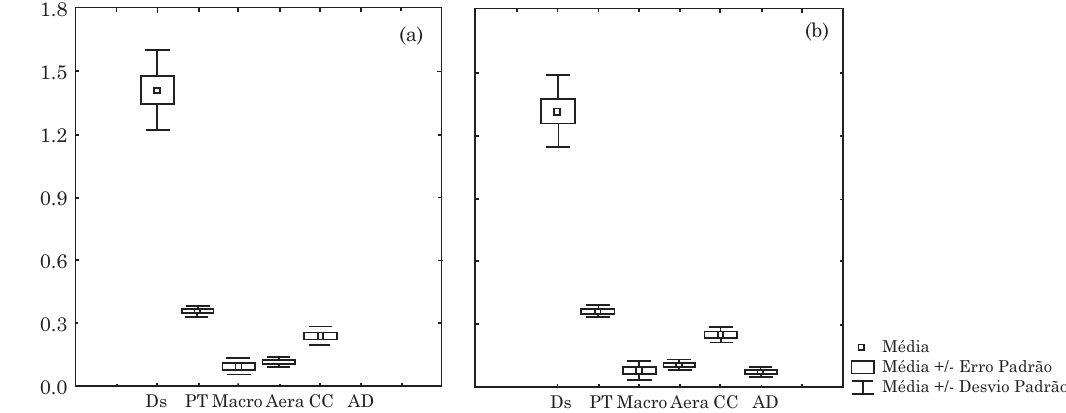
Figura 2. Box-plot indicando a média, o erro-padrão da média e o desvio-padrão (n = 9 em cada posição) dos parâmetros físicos dos horizontes BAx de solos coesos do segmento superior (A) e inferior (B) da topossequência no município de Itaboraí, RJ. Ds: densidade do solo, PT: porosidade total, Mp: macroporosidade, Ae: porosidade de aeração, CC: capacidade de campo e AD: água